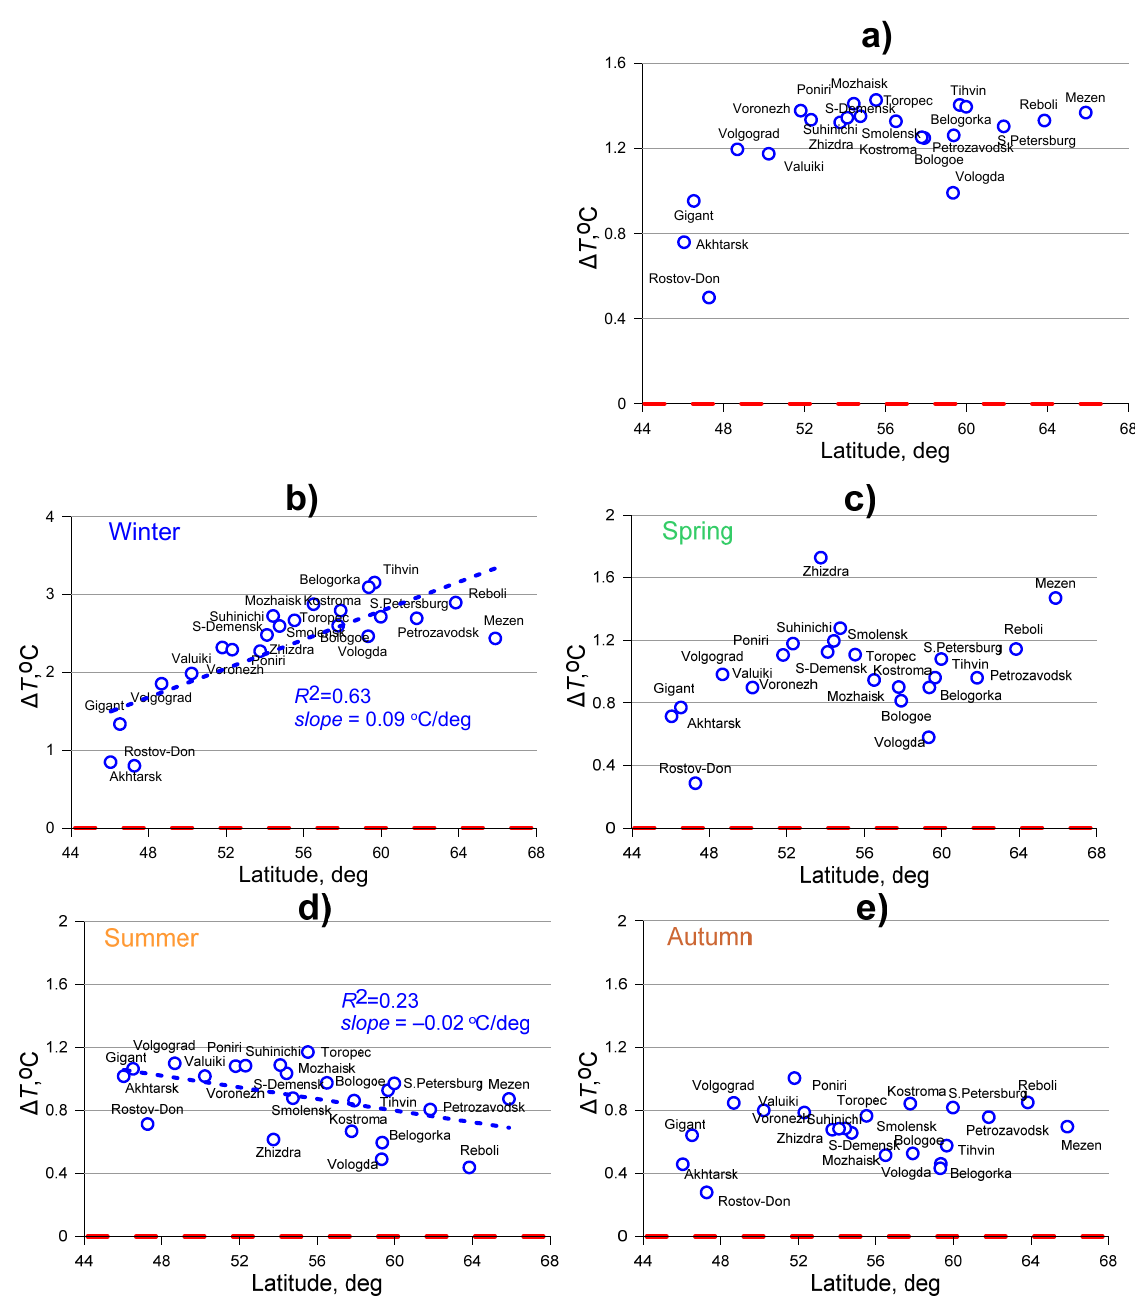
Figure 6. Latitudinal changes in long-term average annual ( a ) and seasonal ( b )-( e ) air temperature ∆ T in the modern period and their linear trends (blue dashed lines).